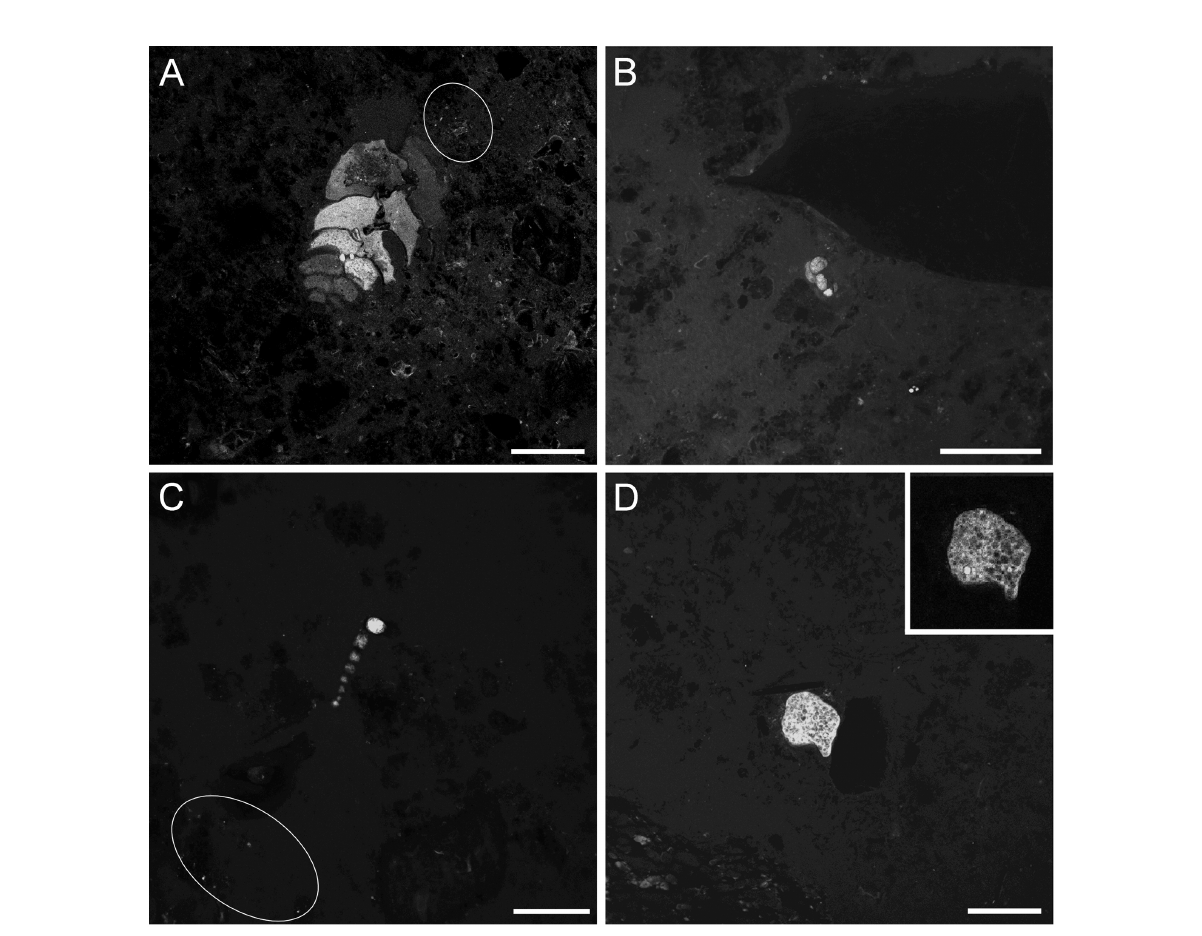
FIGURE 9 LSCM images (z-stacks) of selected foraminifera from chimney-base sediments in FLEC sections. (A) Biserial calcareous form, possibly Euloxostomum pseudobeyrichi from 4-mm depth in Core 9. (B) Multi-chambered enrolled foraminifer (Core 17, 3 mm depth), also likely with a (dissolved) calcium carbonate test. (C) Uniserial agglutinated form near the sediment-water interface (Core 19, ~0.5 mm depth). (D) Single- chamber agglutinated foraminifer; test sediment grains range from small platelets to silt/sand grain on right (Core 10; 0.5 mm depth). Inset: single scan illustrating typical vacuolar nature of foraminifer ’ s cytoplasm. Bright circular structure is likely nucleus. White ovals in A , C highlight areas of microbe aggregation. Number of images compiled/distance between images ( m m): (A) =11/1.4; (B) =34/0.5; (C) = 20/0.7; (D) = 11/0.7; (D) Inset = 1 slice. Scales: (A) = 200 m m; (B-D) = 100